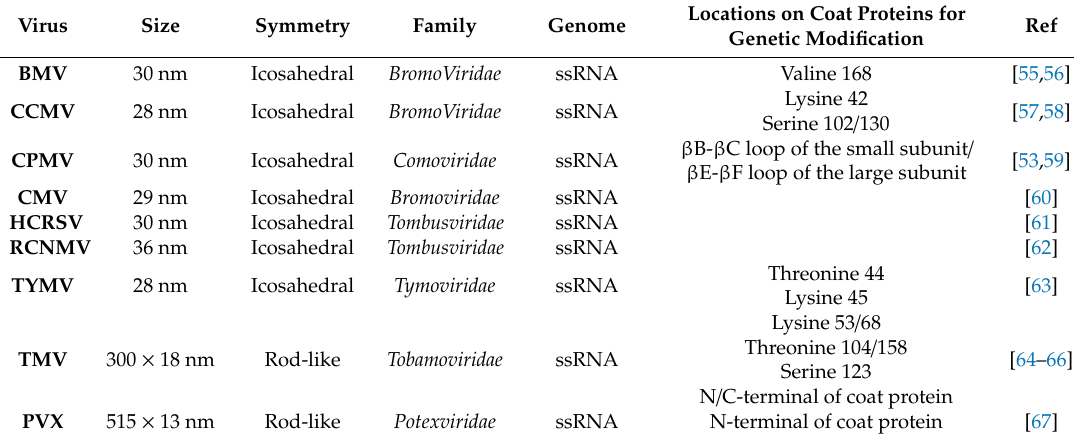
Table 1. Plant viruses used in drug delivery